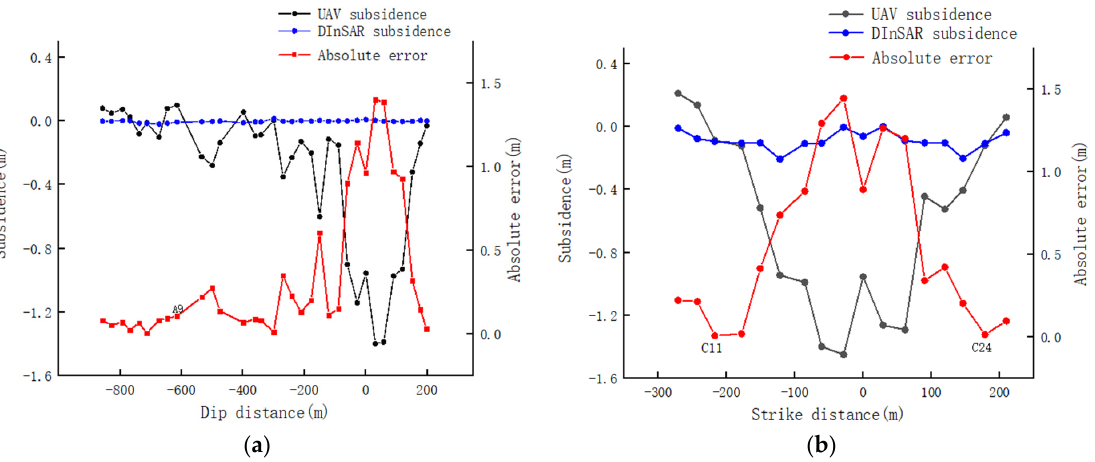
Figure 8. Comparison of DInSAR and UAV monitoring values along line A ( a ) and line C ( b ).